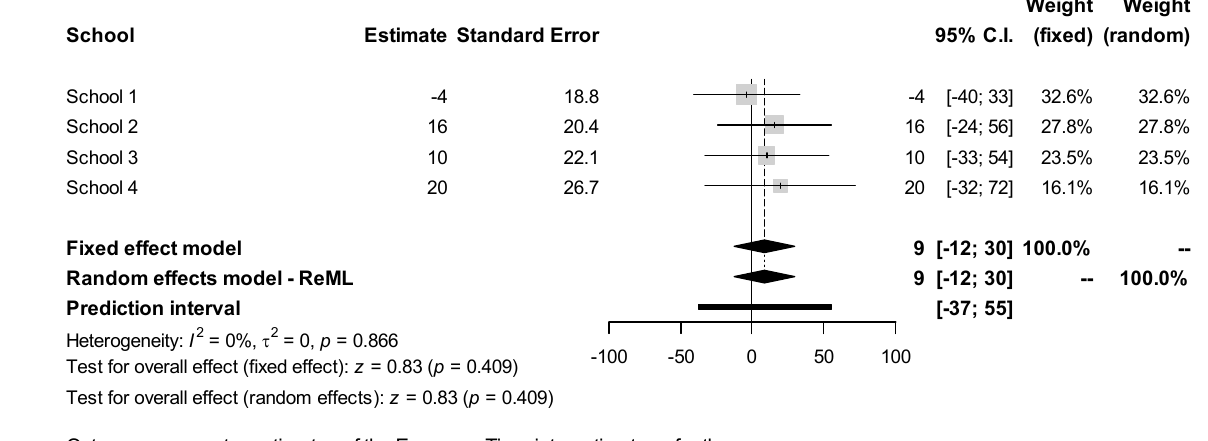
Figure 6. Meta ‐ analysis for test response reaction time variability. Figure 6. Meta-analysis for test response reaction time